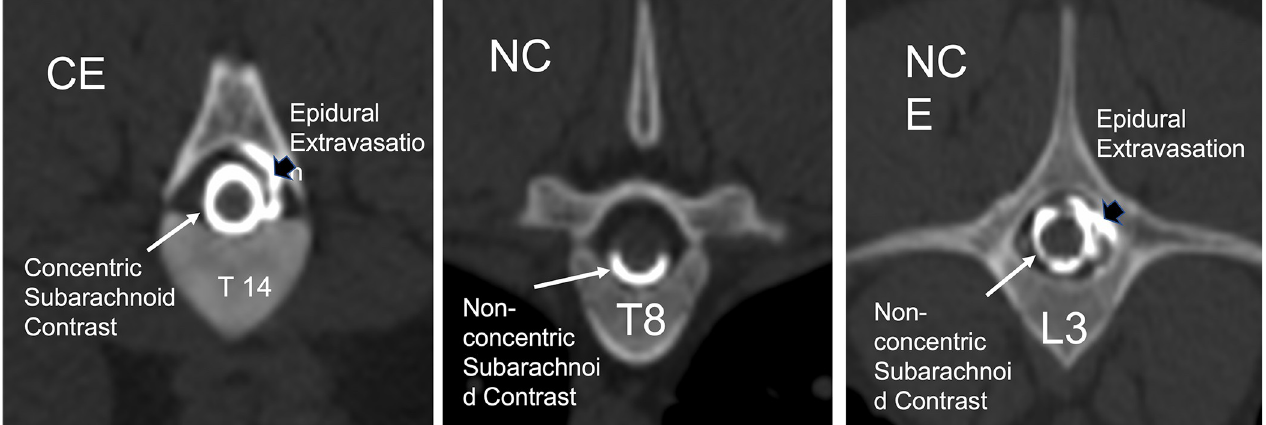
Fig 5. Transverse CT myelogram images showing the qualitative descriptions for contrast filling morphology. (C = concentric, NC = Non-concentric) and presence of epidural extravasation (E = epidural extravasation), or a combination of epidural contrast and non-concentric filling (NCE) or CE for concentric with epidural